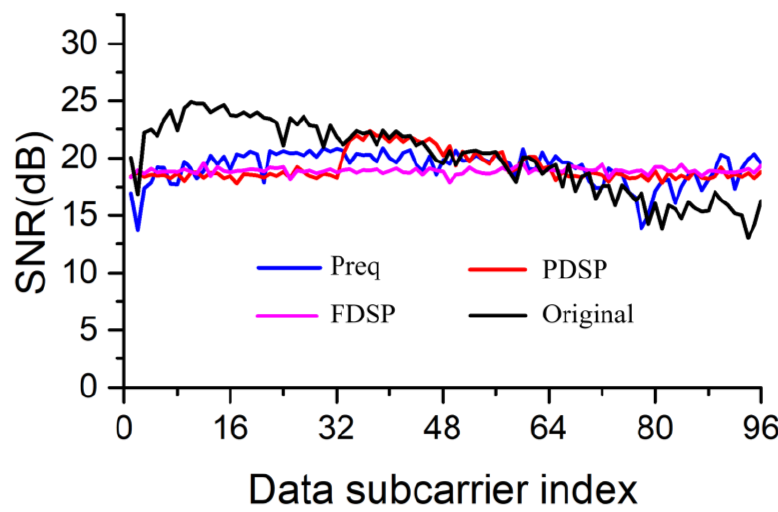
Figure 7. The estimated SC SNR for four kinds of received PS-DMT signals.